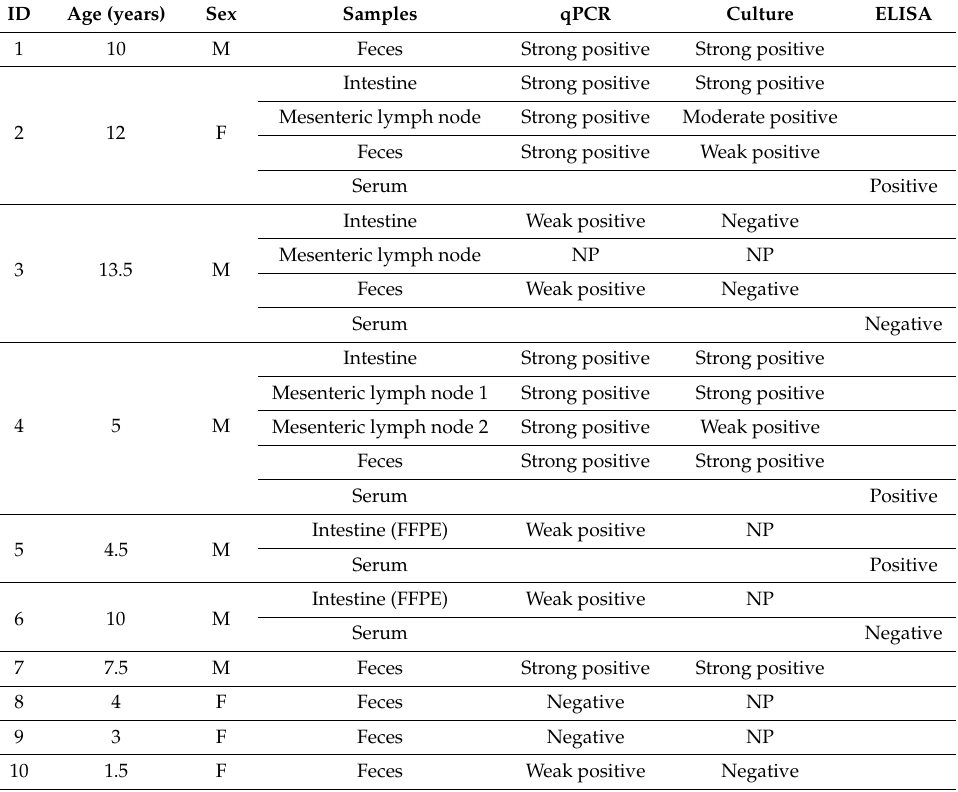
Table 1. Summarized matrices and results of cultural, molecular, and serological